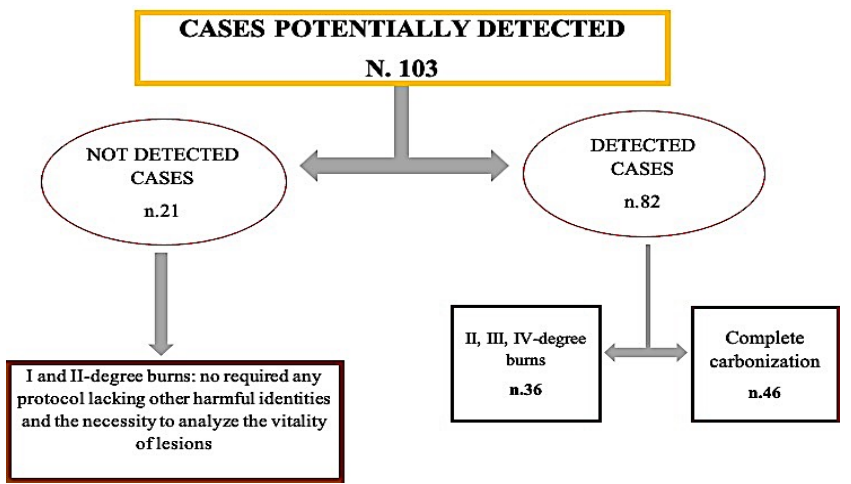
Figure 2. The diagram presents the selection method from a total of 103 cases. Only those belonging to the second group [82 cases] were selected for our